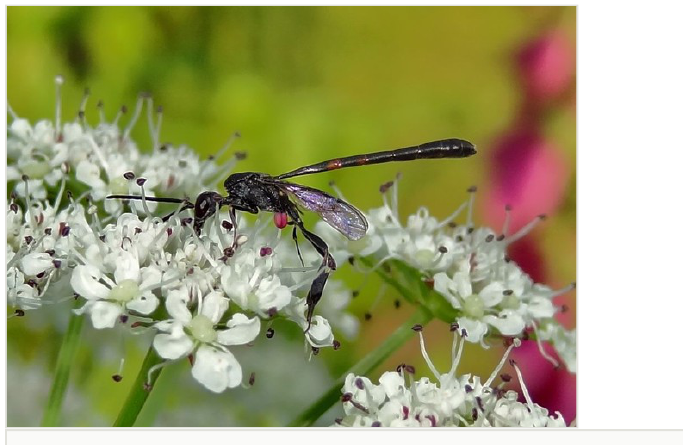
Figure 1. Male Gasteruption jaculator (Linnaeus) (Wilmslow, Cheshire) (courtesy of A.M.